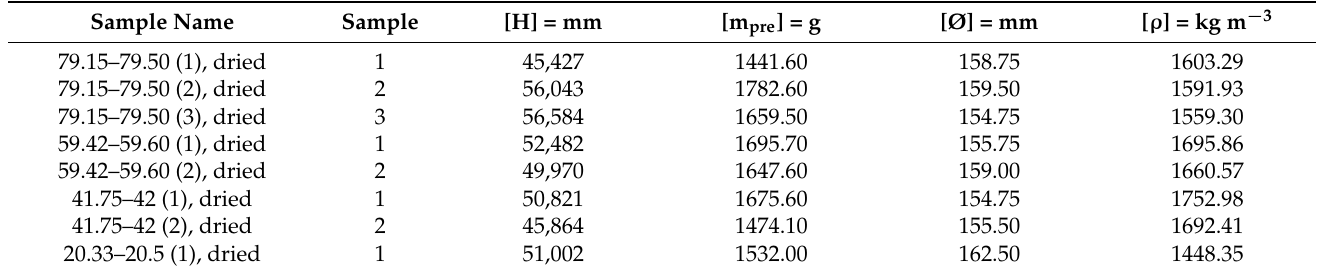
Table 3. Dried HFM sample dimensions and mass properties from the drill cores at different depths.